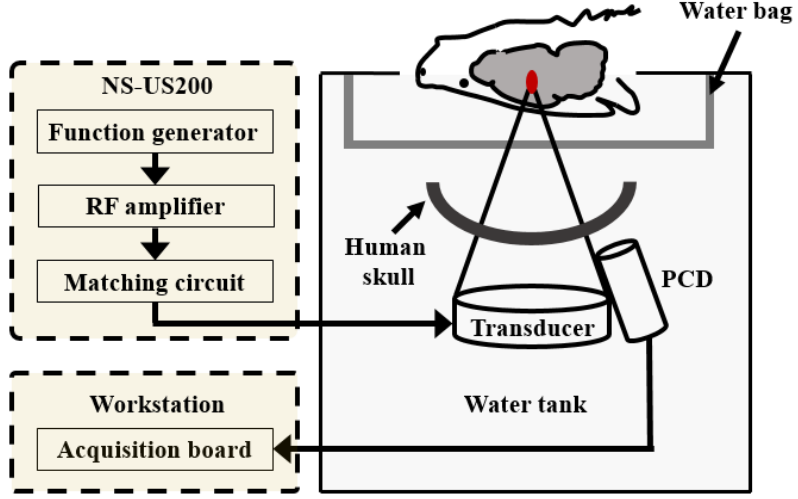
Figure 1. Schematic of the focused ultrasound (FUS) system and experiment environment for blood- brain barrier disruption (BBBD) in the rat. The rat was placed upside down on the surface of the water. The convex part of the human skull was placed toward the transducer similar to that in the clinical trial environment.